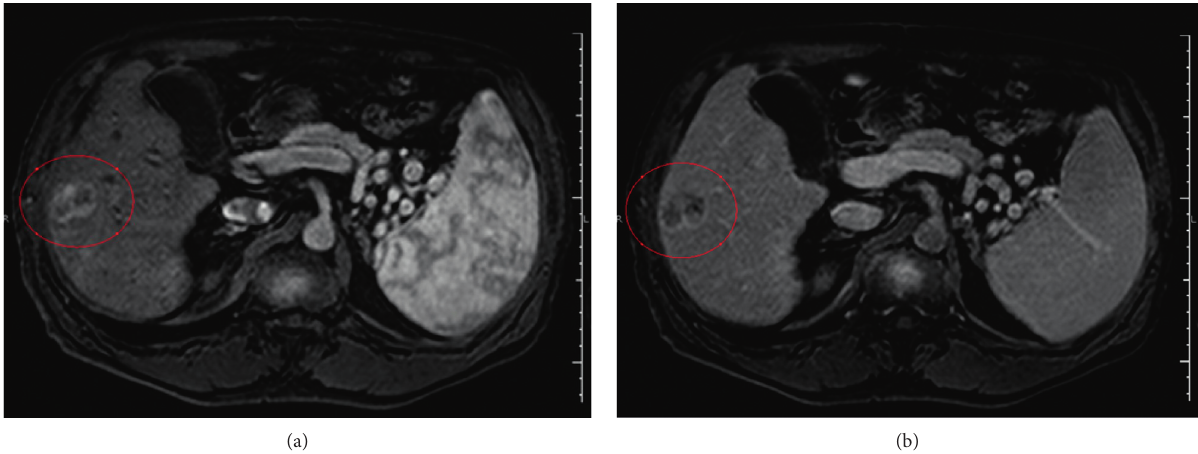
Figure 1: Magnetic resonance imaging performed on March 31, 2017, showing the initial liver tumor that measured 3.0 × 2.5cm in liver segment VI with arterial enhancement and a marked washout in the portal phase (the tumor is underscored by the red line). (a) Arterial phase. (b) Portal